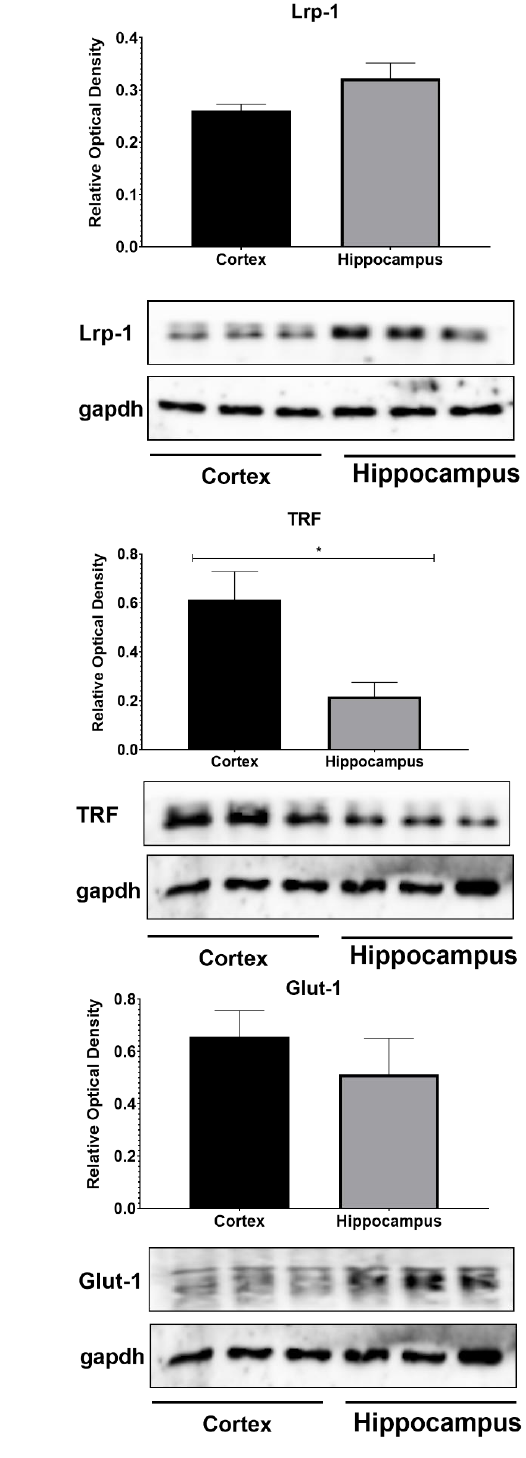
Figure 5. Levels of the receptor (Lrp-1, transferrin receptor and GLUT-1) in mouse brain micro vessels isolated from the cortex and the hippocampus. ( A – C ) The relative mRNA levels of Lrp1 ( A ), TRF ( B ), and slc2a1 ( C ) were assessed through real-time PCR. GAPDH was used as an internal standard. Data are represented as (2 −ΔCt ). The protein expressions of Lrp-1 ( A ), TRF ( B ), and GLUT-1 ( C ) were examined by Western blot. Optical densities were analyzed with Image Lab 6.0.1 software (Bio-Rad) and normalized to GAPDH. Results are the means ± SEM from three lots of brain endothelial micro vessels (each lot represents a pool from five mice). Statistical comparisons: * p < 0.05 and ** p <